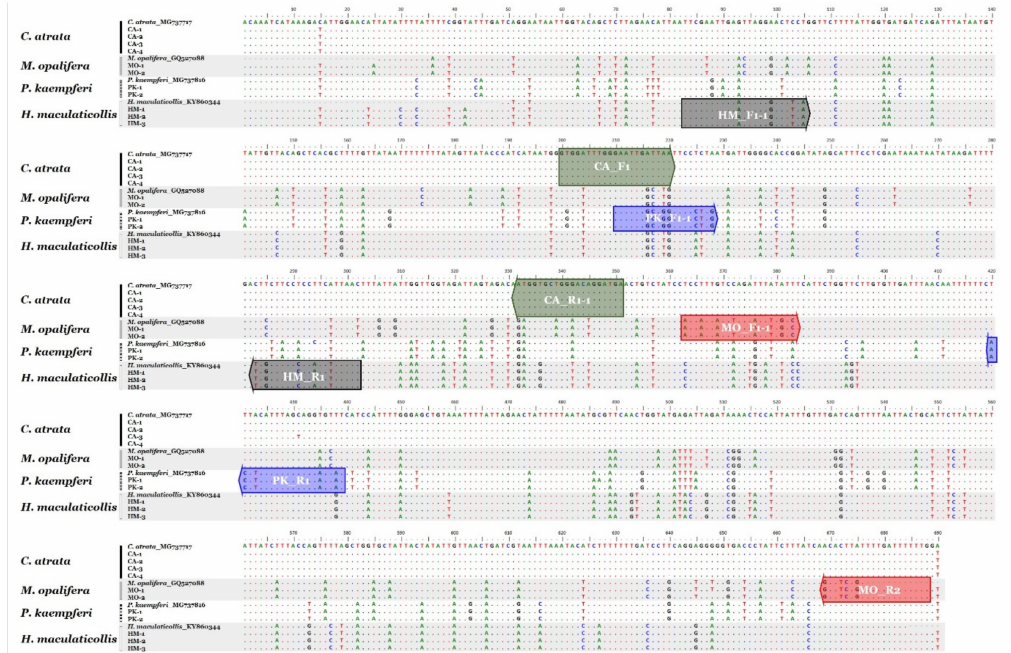
Figure 1. Comparative sequence analysis of cytochrome c oxidase subunit I (COI) region in four cicada species. Positions and directions of four species-specific primer pairs (box-shaped arrows) displayed on sequences.